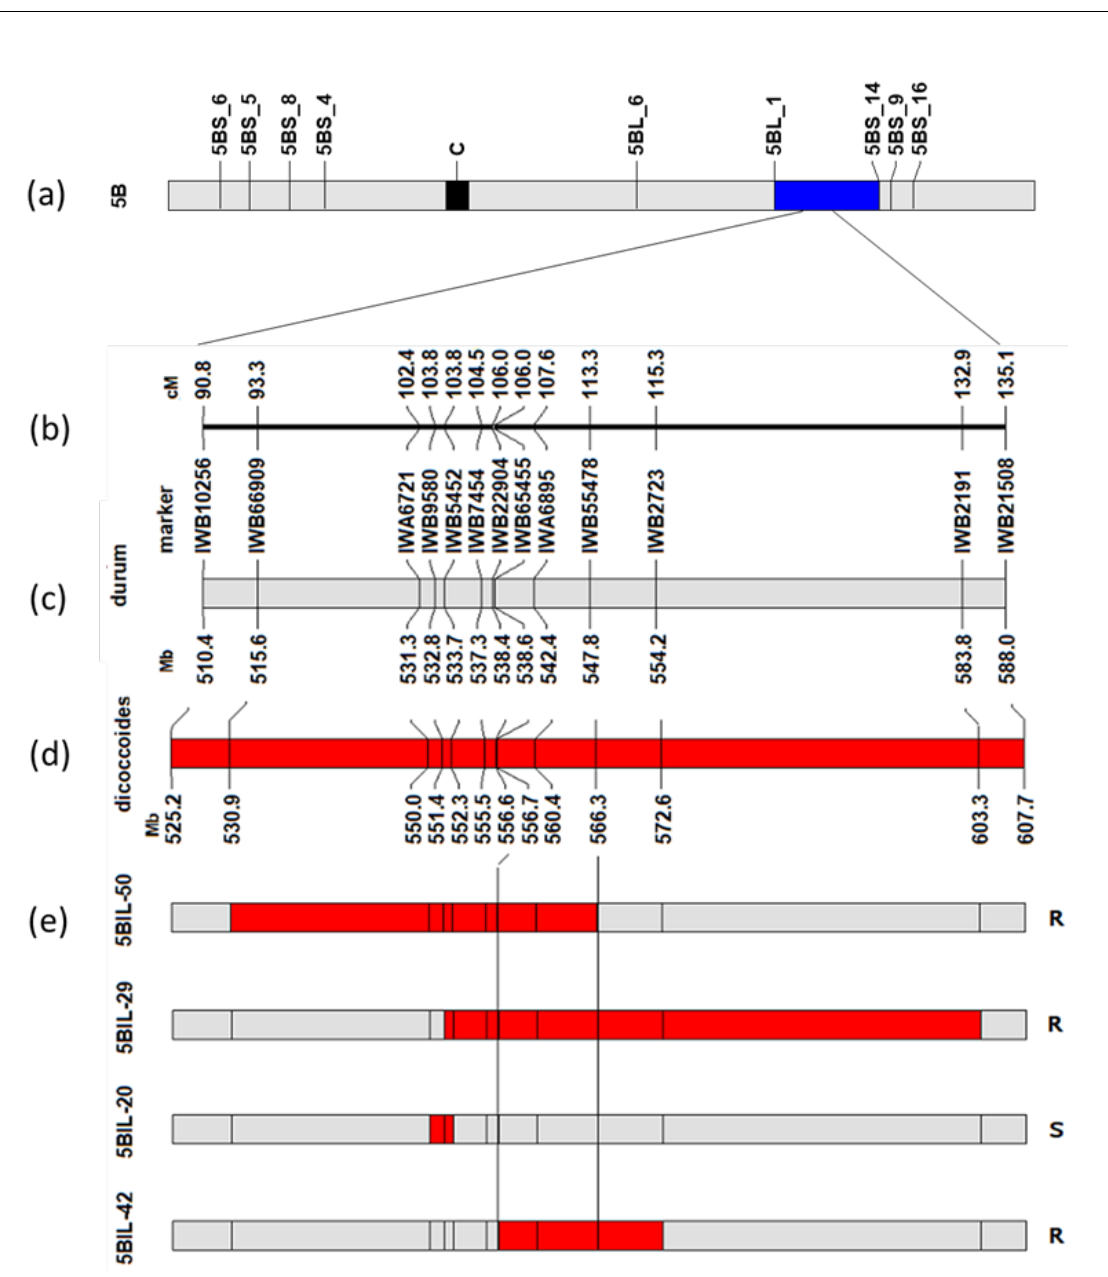
Figure 1. Fine mapping of the wild emmer-derived powdery mildew resistance Pm36 locus using homozygous backcross inbred lines (BILs) of durum wheat. ( a ) Physical location of Pm36 on the 5BL chromosome arm (bin 5BL_1) (blue block); ( b ) Genetic map of the 5BL region harboring Pm36 with the genetic position (cM) of relevant SNP markers according to the consensus durum map [44]; ( c , d ) Schematic representation of the durum wheat Svevo reference genome (grey block) [45] and the dicoccoides Zavitan reference genome v2.0 (red block) [46] with the physical position (Mb) of relevant SNP markers; ( e ) Genotype and phenotype of four BILs (5BIL-50, 5BIL-29, 5BIL-20, 5BIL-42). S and R on the right of the bars indicate susceptible and resistant phenotype, respectively. Gray and red rectangles represent the genotypes of the PM-susceptible durum wheat Latino and the PM-resistant lines, respectively. Pm36 was placed within a 7.3 cM interval flanked by IWB55478 and IWB22904 (between two vertical lines) based on the genotypes of the BILs at the marker loci and their PM phenotypes.